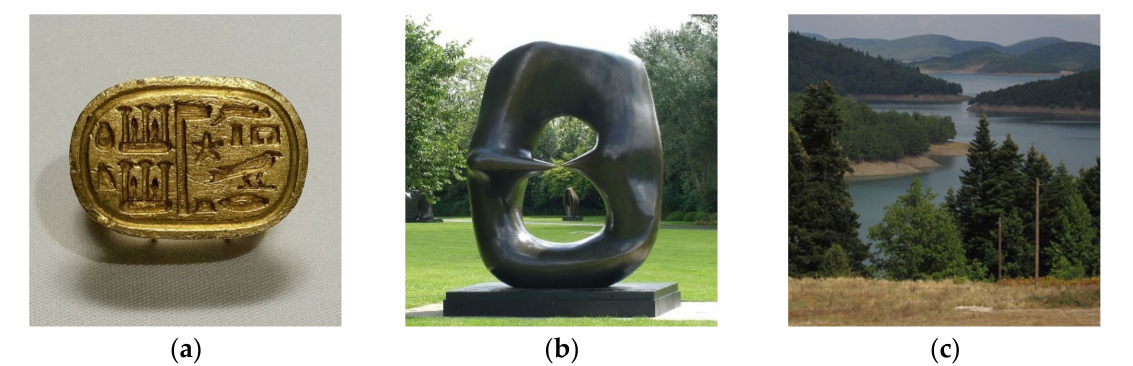
Figure 1. Focus Points ( a ) Signet ring; Egypt; 664–525 BC; gold; dimensions: 3 × 3.4 cm; British Museum (London) with a few centimeters ZTV [44]; ( b ) Statue by Henry Moore, Oval with Points, height 3.32 m, 1970; with a few hundred meters ZTV [45]; ( c ) Plastiras Lake landscape created by an artificial lake of 24 km 2